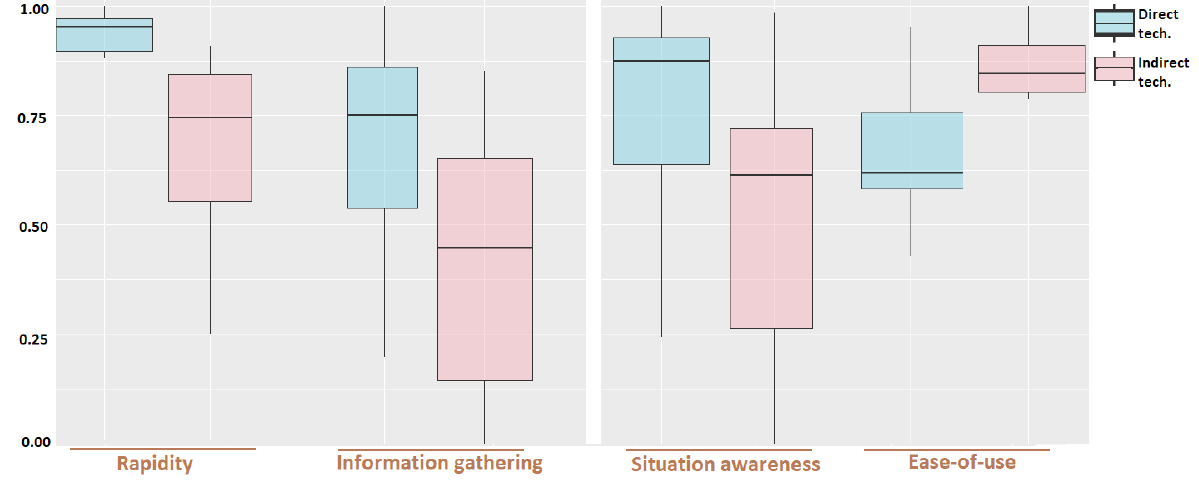
Figure 11. Quality factors scores distribution—within HMD subjects data.